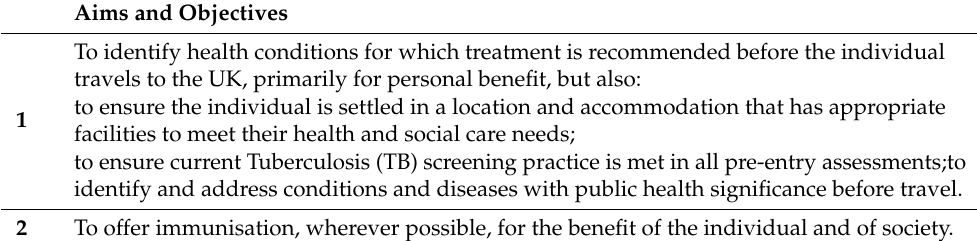
Table 1. UK Medical Health Assessment (MHA) aims and objectives. Aims and